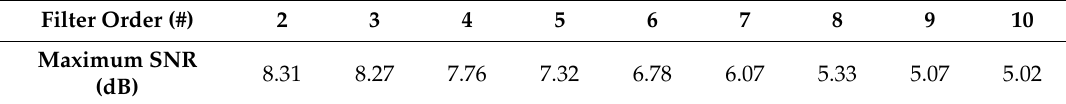
Table A1. Maximum SNR achieved for each filter order on FEM test signal with 30 kHz signal. Filter Order (#)